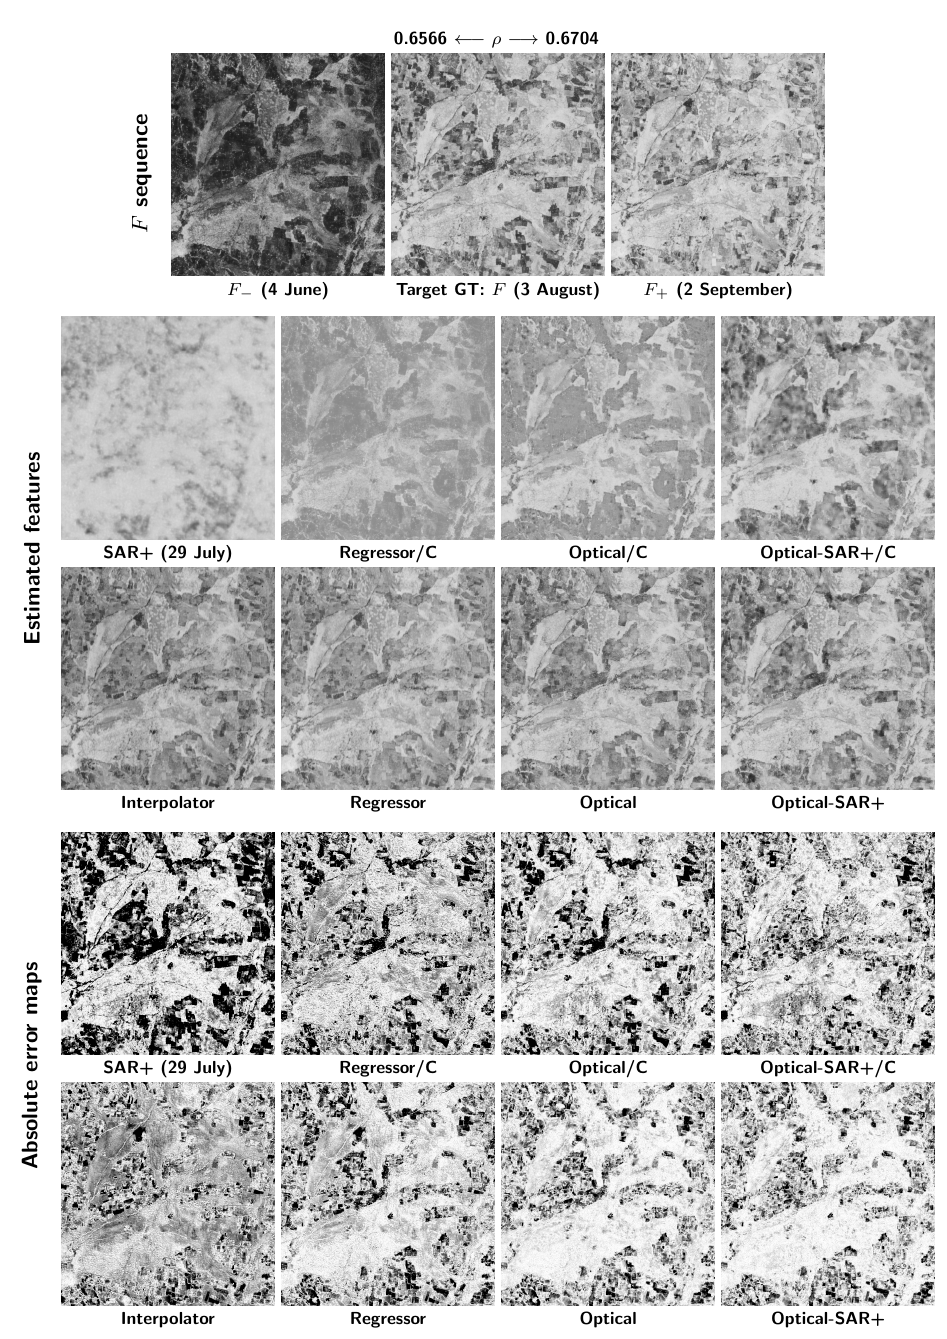
Figure 6. Sample results for the 3 August target date. Top row : previous, target and next NDVI maps of the crop selected for testing. Second/third rows : NDVI maps estimated by causal/non-causal methods. Last two rows : corresponding absolute error